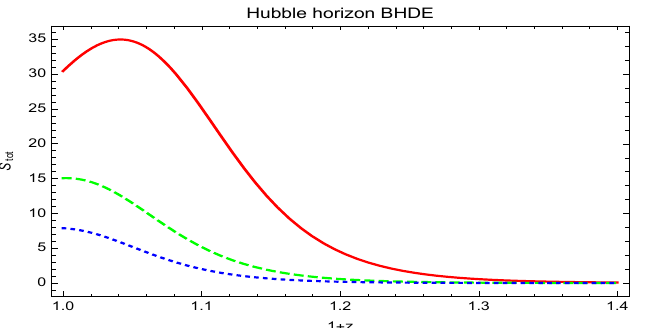
+ z for interaction interacting BHDE model with Figure 13. Plot of S (cid:48) tot versus redshift parameter 1 Hubble horizon under GDP braneworld